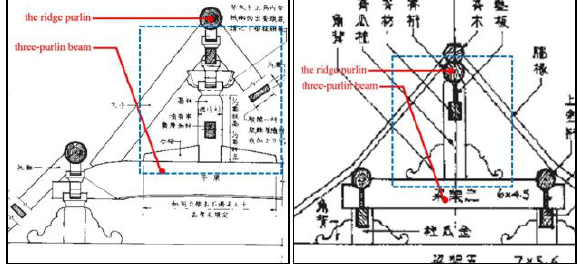
Figure.6 the post-and-panjian dougong combination(left) and the post pedestal-and-post combination(right) Table.1 types of the post-and-post pedestal combination